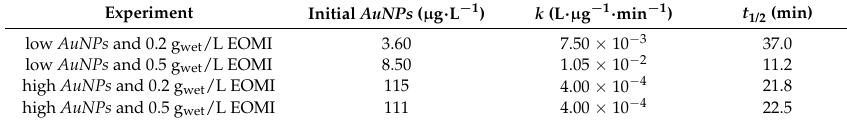
Table 1. Parameters of second order rate equation (Equation (6)) of AuNPs adsorption onto EOMI.